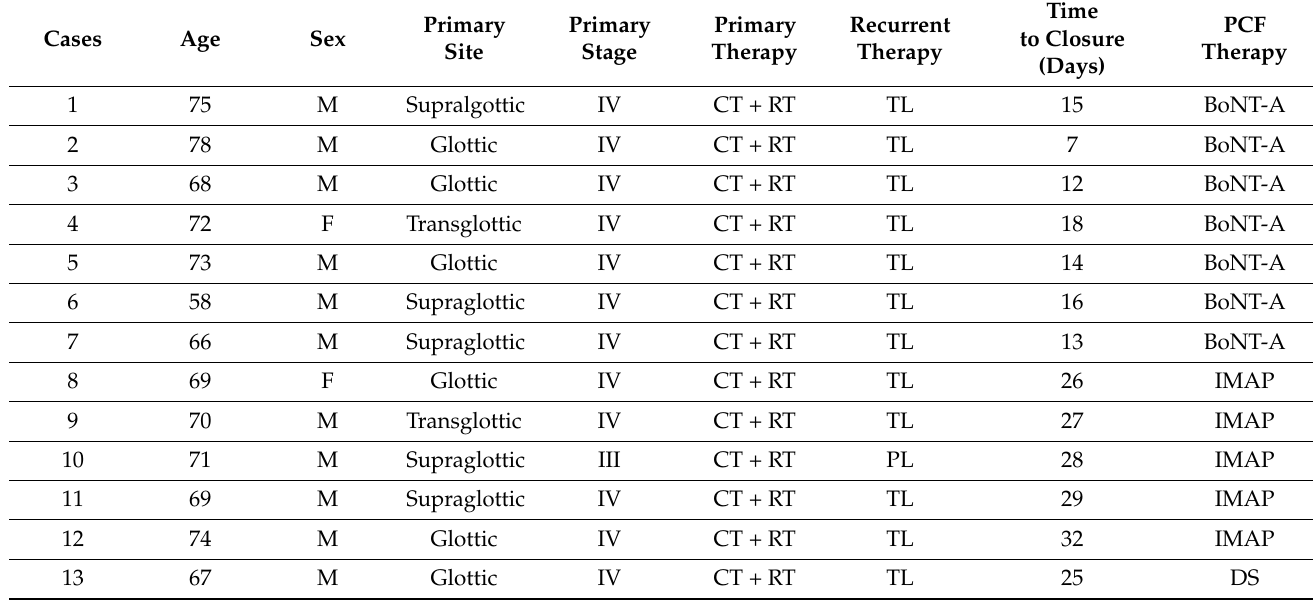
Table 1. Demograhic, oncological, and treatment data of the